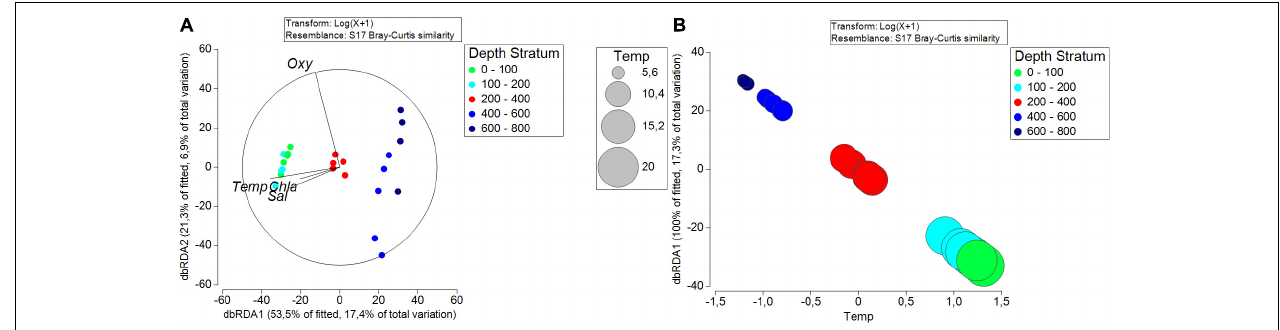
FIGURE 8 | (A) The distance-based redundancy analysis (dbRDA) ordination plot relating the structure of the copepod community across the depth layers and stations. Data points indicate different study sites (SPSG), and their colors indicate the depth layer of samples. The length of each vector represents the importance of the oceanographic variable (Temp = temperature, Sal = salinity and Oxy = oxygen), while the direction shows the correlation with these samples, and the circle shows the threshold for a correlation = 1. (B) dbRDA bubble plot of the DISTLM sequential test showing temperature as the predictor variable to explain the variation of copepods community in the